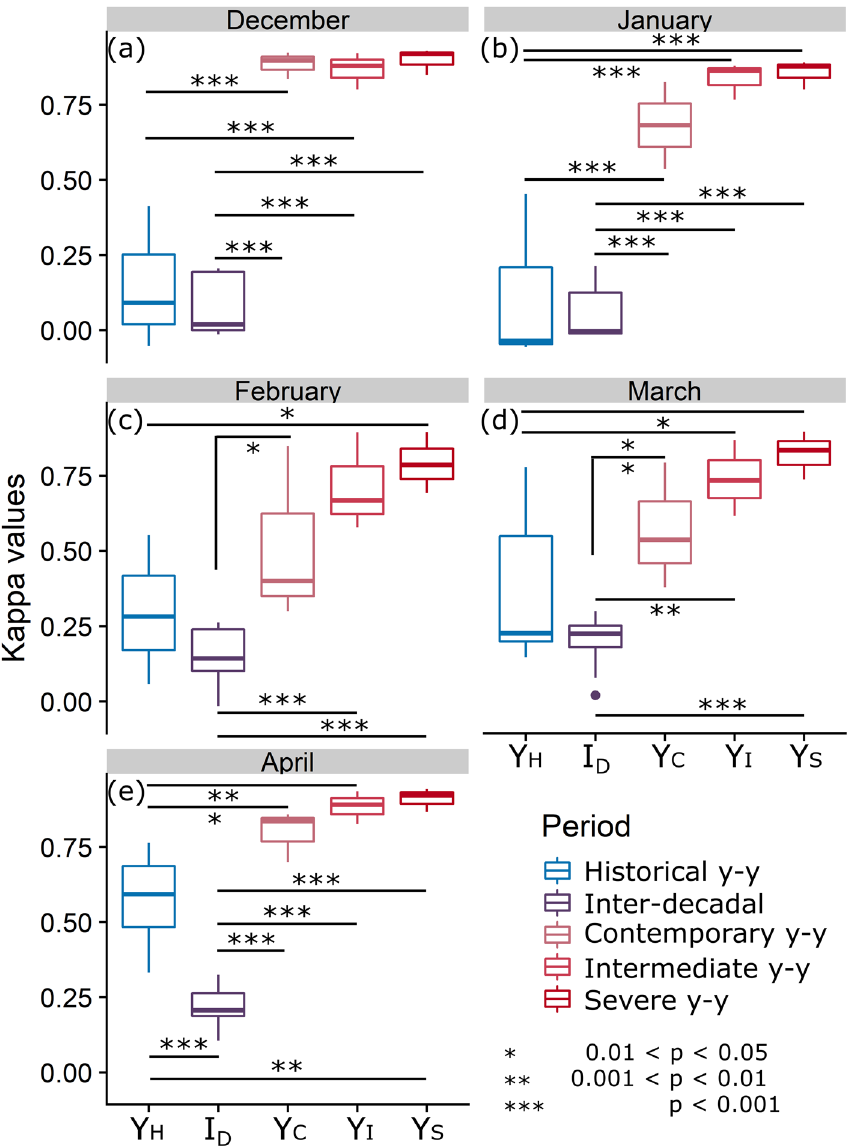
Figure 4. Kappa coefficients comparing the relative probability-of-use by month. Y H : year-to-year (y–y in the legend) comparisons for historical study period using RSF h ; I D : inter-decadal comparisons; Y C : year-to-year comparisons for contemporary study period using RSF c ; Y I : year-to-year comparisons for intermediate forecast scenario; Y S : year-to-year comparisons for severe forecast scenario. Sample size varies based on the number of years for which data was collected in that month (November not shown due to low sample size). Asterisks denote pairwise significance of difference between categories of comparison (***, p < 0.001; **, p < 0.01; *, p <